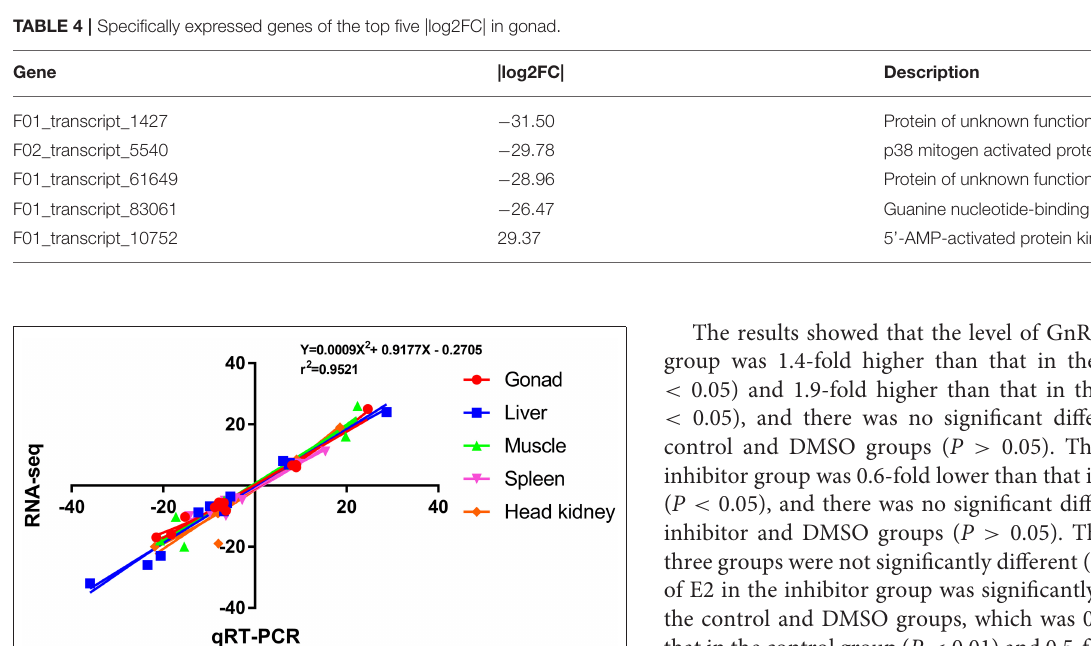
years ph was 2.0-fold of that at 750 dph and 3.1-fold of that at